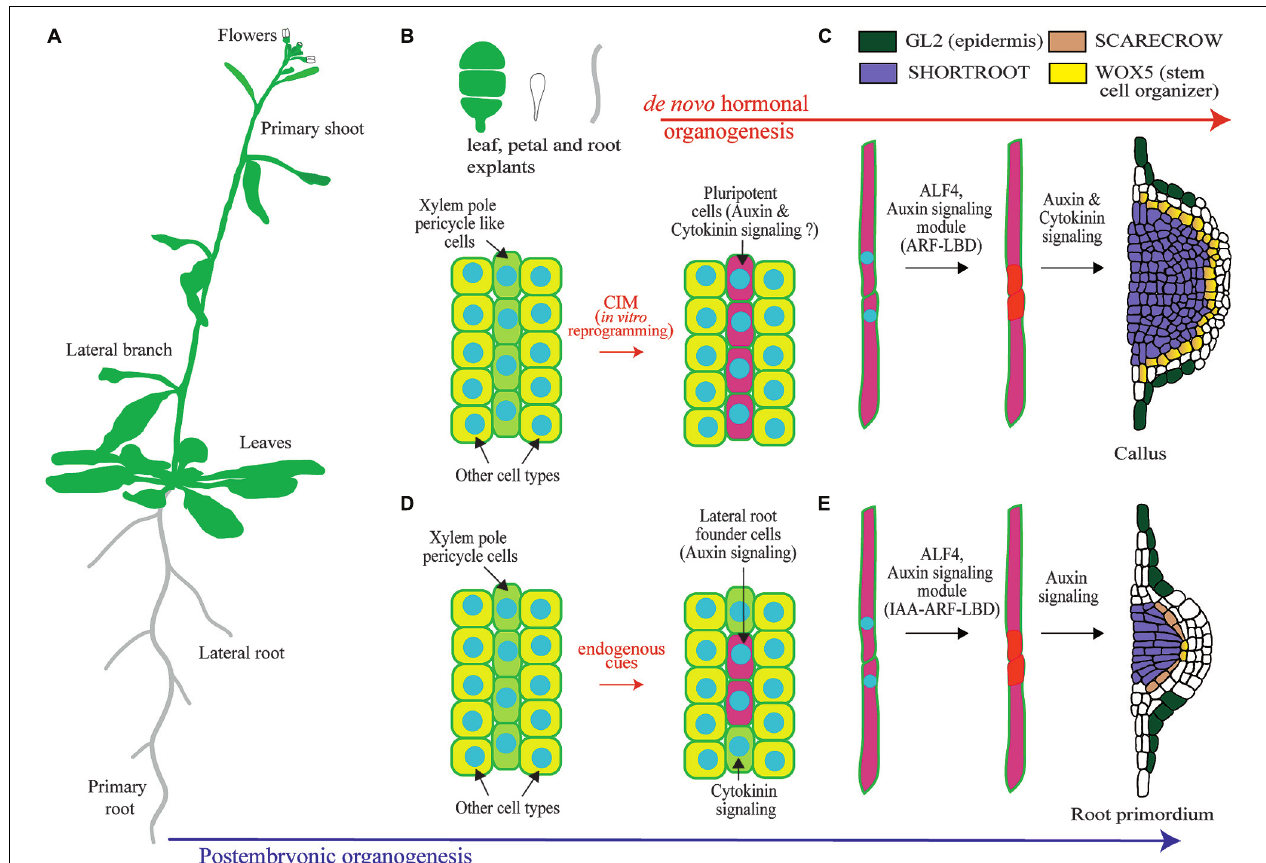
post-embryonic development to form lateral root founder cells. Note that as not all cells are reprogrammed this creates a branching pattern. (E) Lateral root initiation occurs through the asymmetric cell division regulated by ALF4 and auxin signaling. Subsequent divisions create a primordium with stereotypic morphologies and expression of the root regulators SHORTROOT, SCARECROW,WUSCHEL RELATED HOMEOBOX 5 (WOX5), and GLABRA2 (GL2). Note the similarities with callus